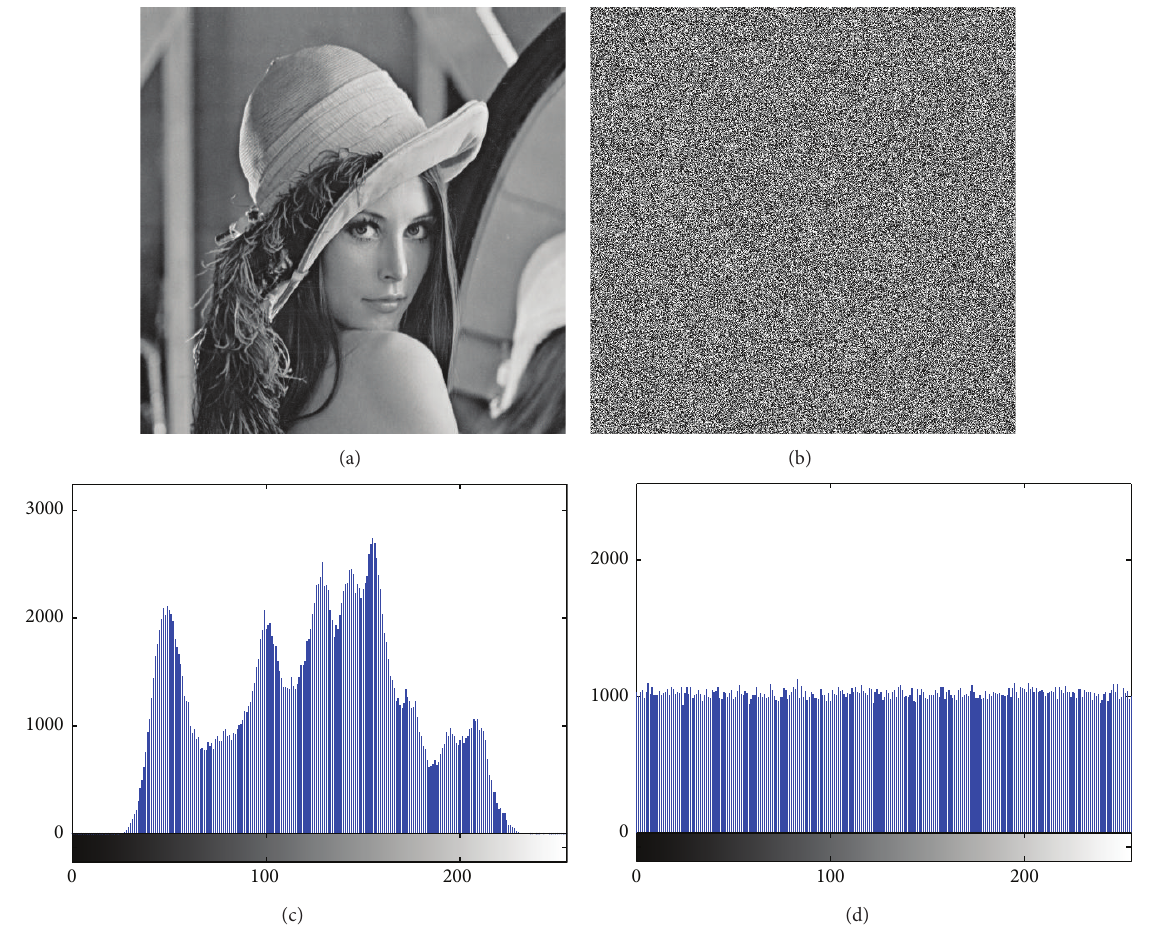
Figure 5: Histogram analysis: frames (a) and (b) show a plain image “Lenna” and its corresponding cipher image, respectively. Frames (c) and (d) show histograms of images shown in frames (a) and (b), respectively.